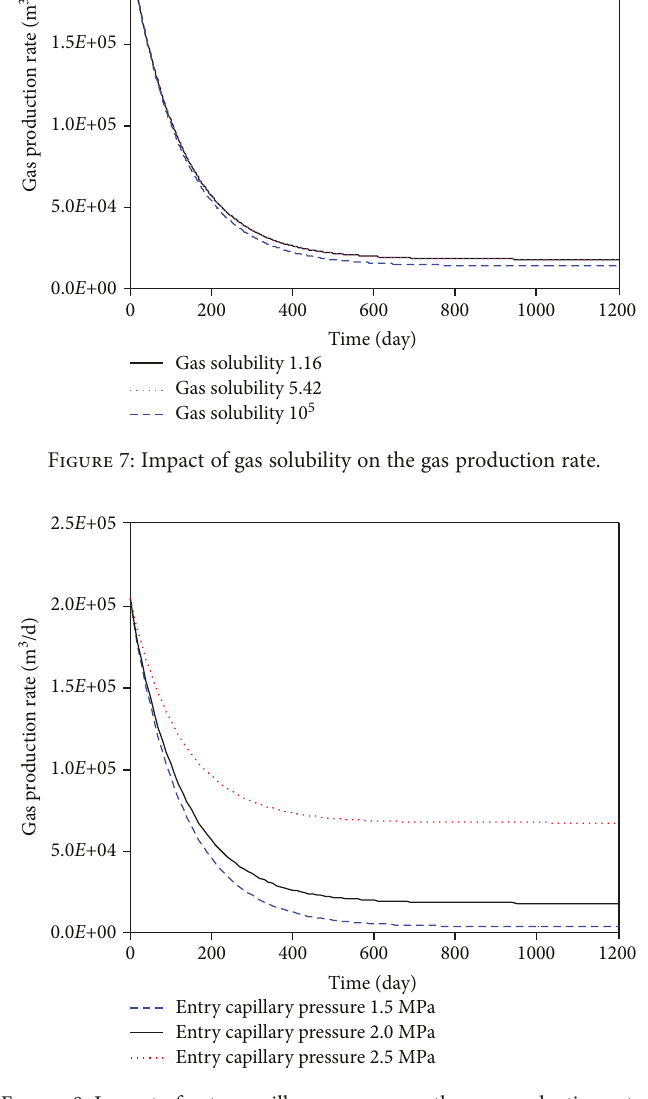
Figure 8: Impact of entry capillary pressure on the gas production